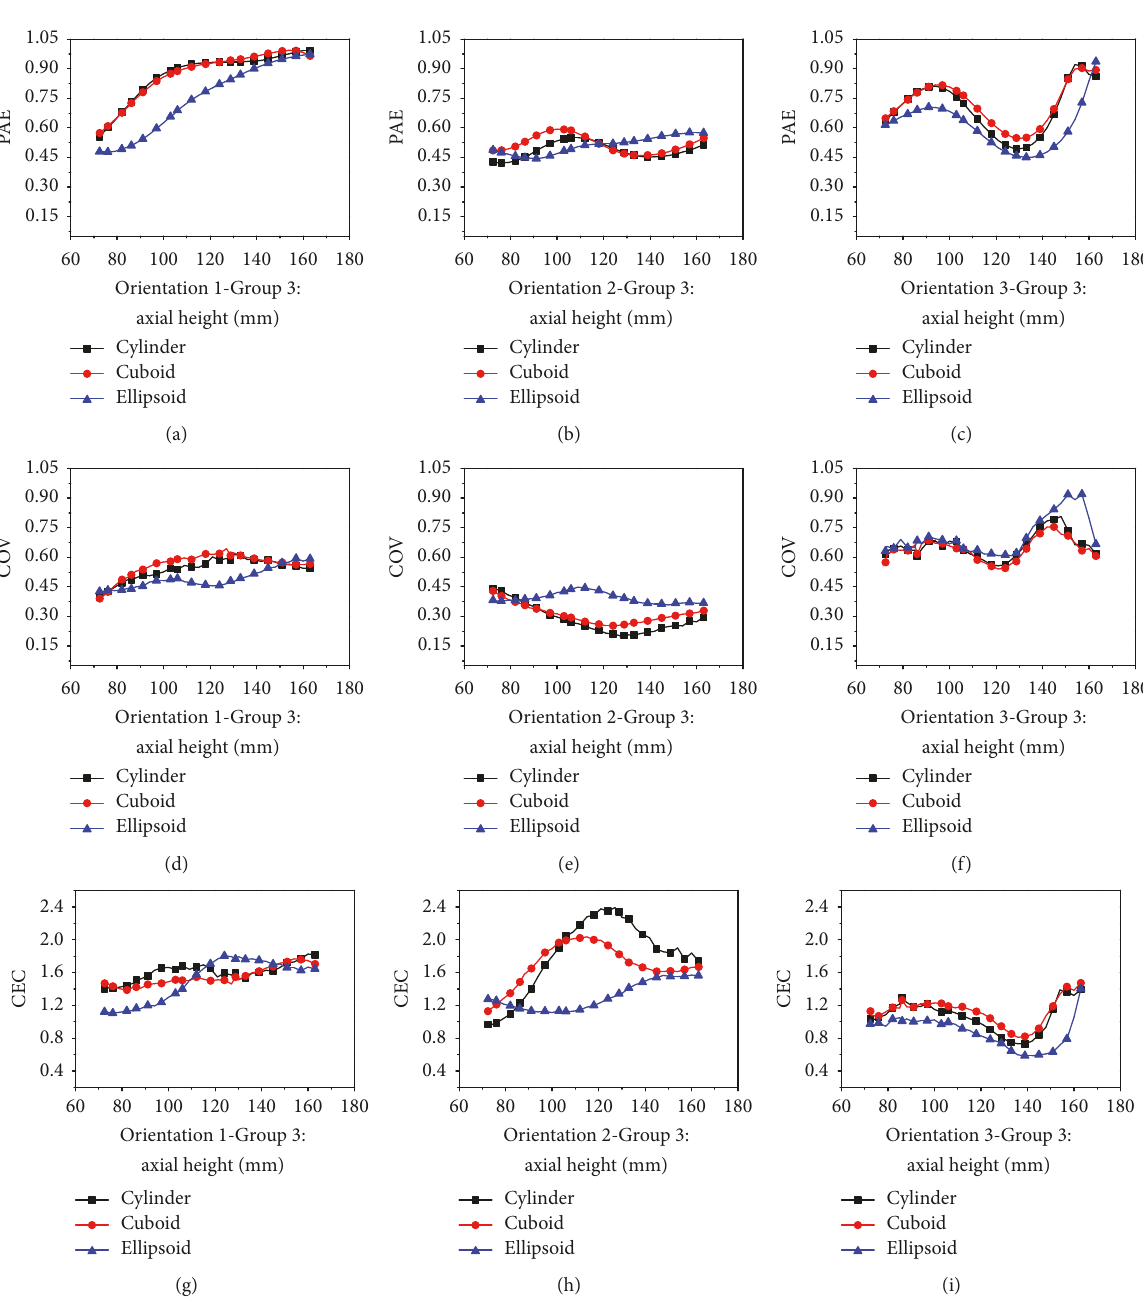
Figure 22: Different samples in the same orientations, Group